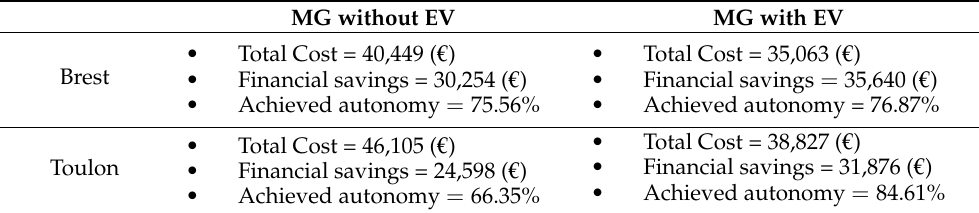
Table 7. Summary of the achieved benefits for 20 years of operation of the home MG in Brest and